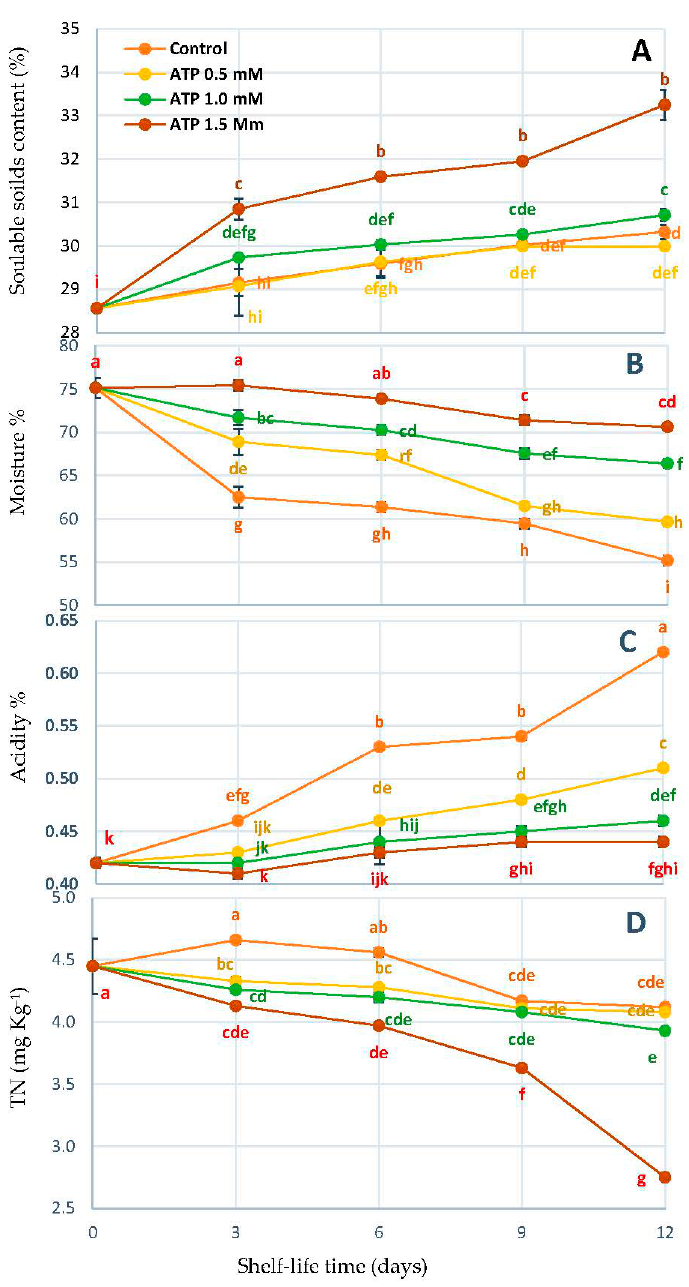
Figure 2. SSC% ( A ), moisture% ( B ), TA% ( C ), and TN ( D ) of ‘Zaghloul’ date fruit treated with ATP at different concentrations (0, 0.5, 1.0, and 1.5 mmol L − 1 ) during storage at 27 ± 1 °C, 67 ± 3% R, for 12 d. Each value represents mean ± SE ( n = 3). The letters differ ( p < 0.05) and represent the signifi- cance between treatments using the Tukey–Kramer HSD test to compare the different